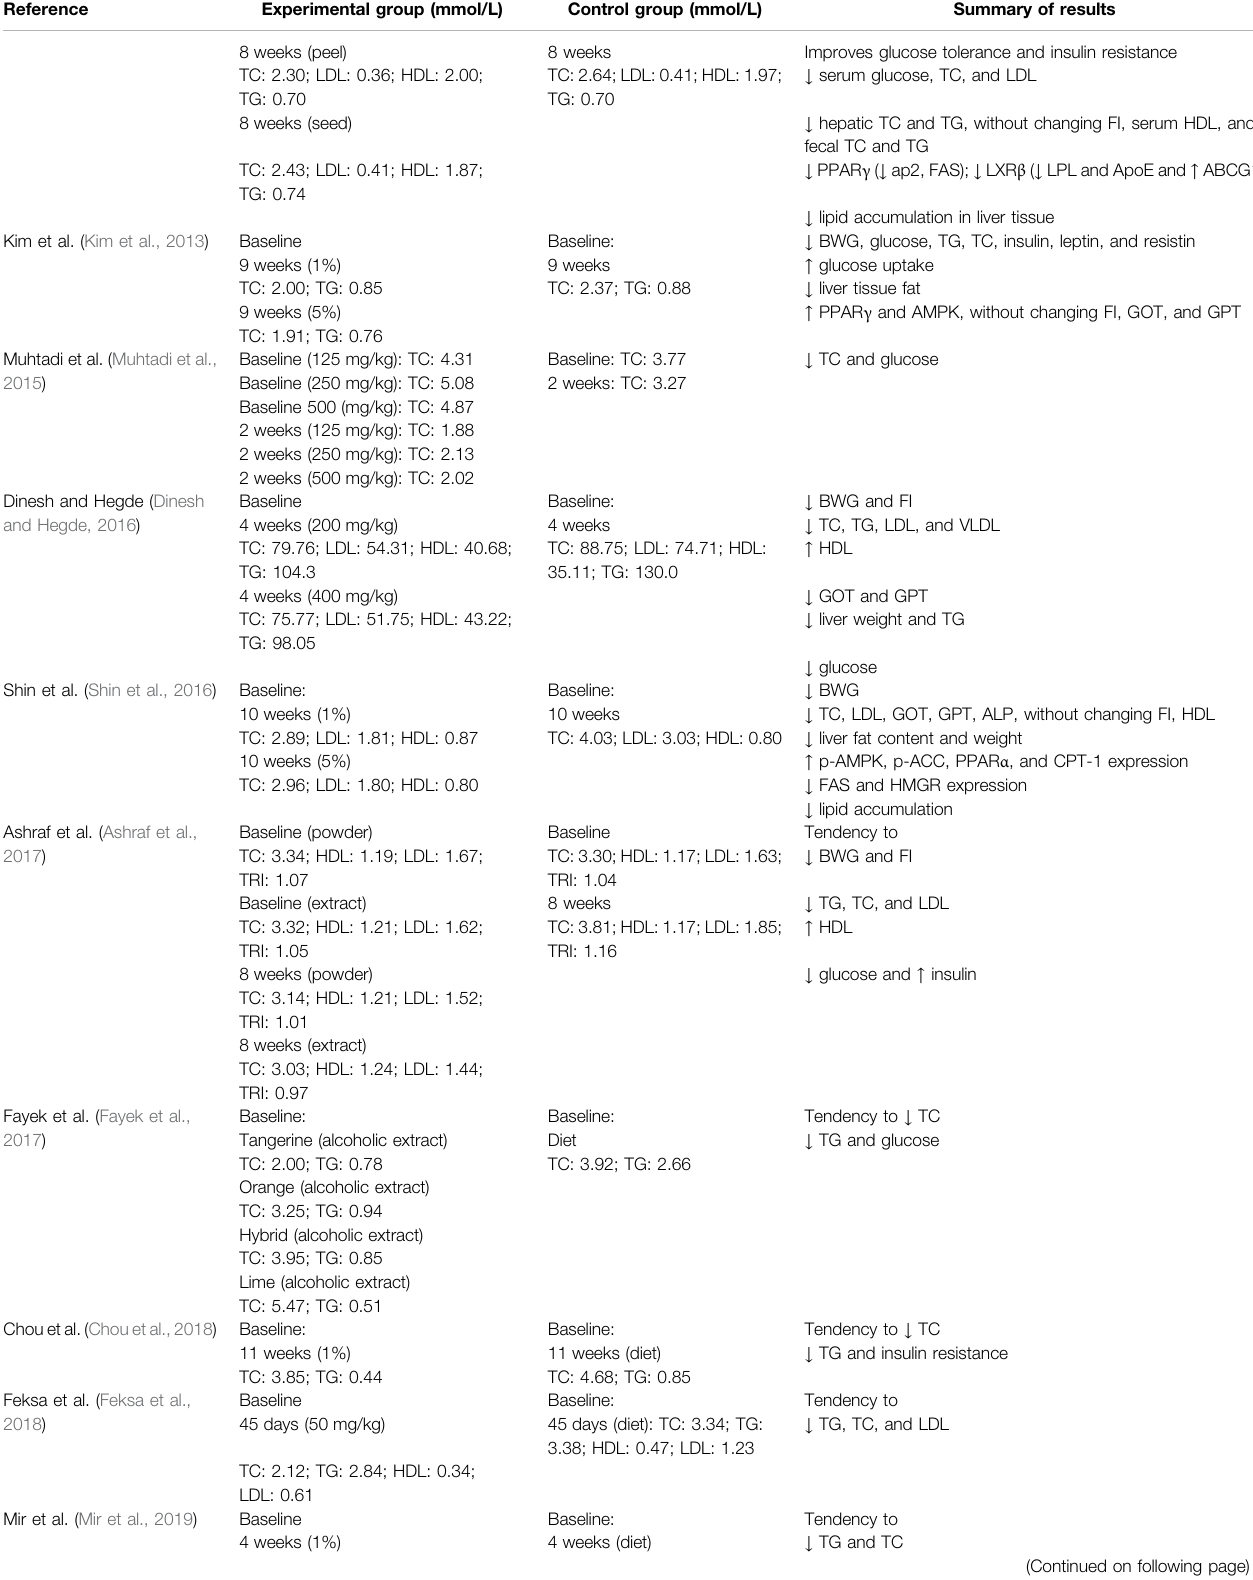
TABLE 2 | ( Continued ) Outcomes of the preclinical studies included in this systematic